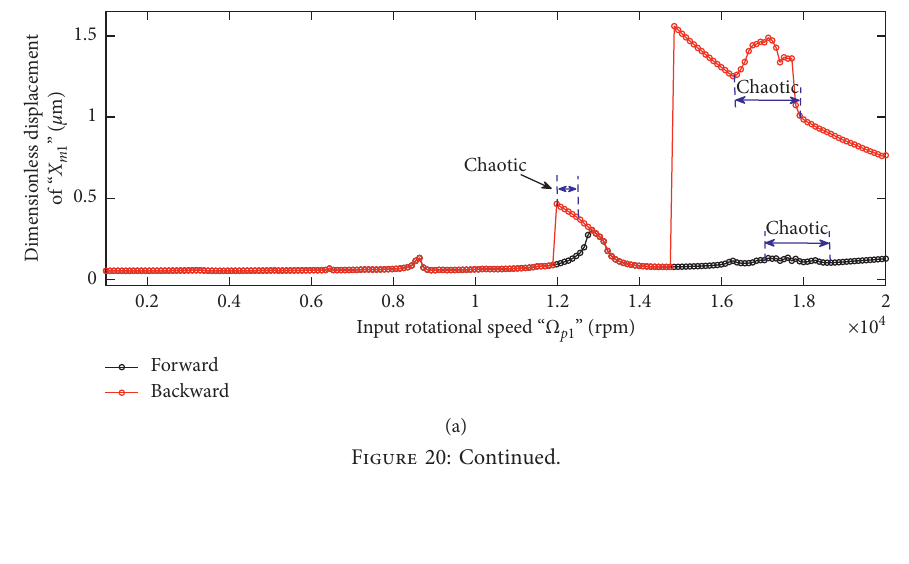
� s � 60 μ m . (a) X 1 2